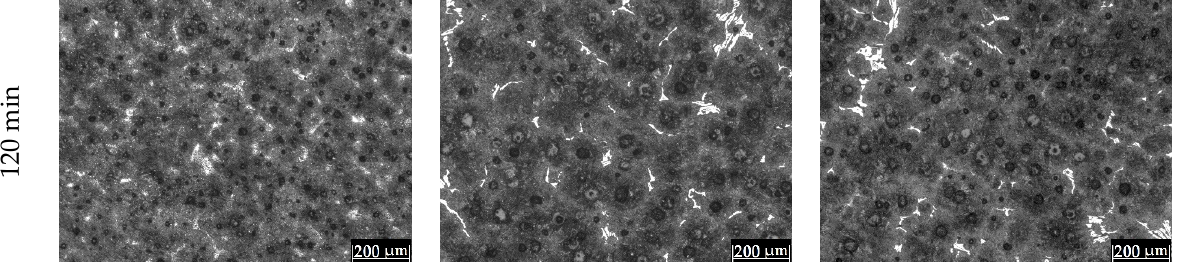
Figure 6. Microstructural evolution for the CADI-0.4Cr-265 sample at the austempering times of 30, 60, 90, and 120 min for the three regions analyzed.